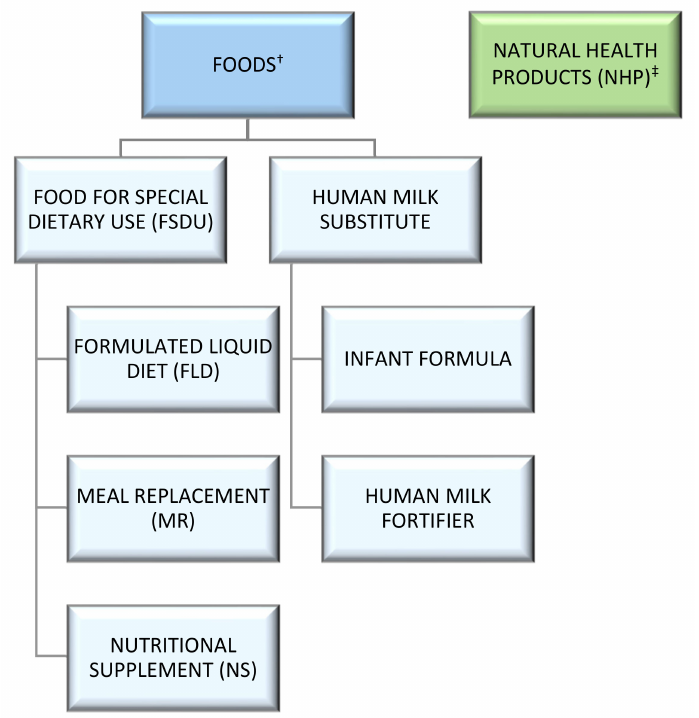
Figure 2. Select * specialized product categories in Canada. * As discussed in this paper. † Foods are regulated by Health Canada’s Food and Drug Regulations (FDR). ‡ Natural Health Products are regulated by Health Canada’s Natural Health Product Regulations (NHPR); NHP categorization depends on characterization, formulation, history, and public